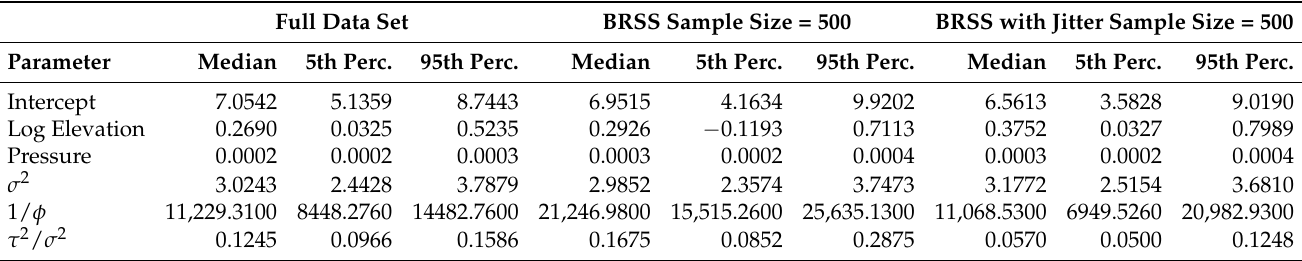
Table 1. Kriging Models of Logged Natural Gas Production in West Virginia for